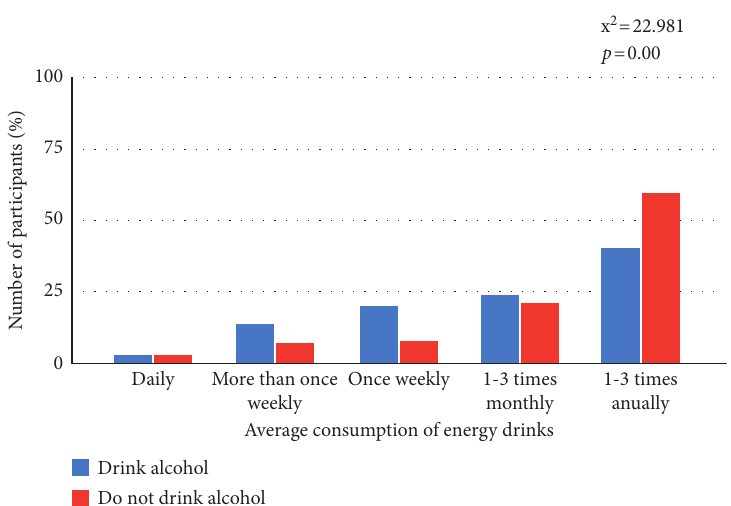
Figure 2: Pattern of consumption of energy drinks between energy drink consumers who drink alcohol and those who do not drink.